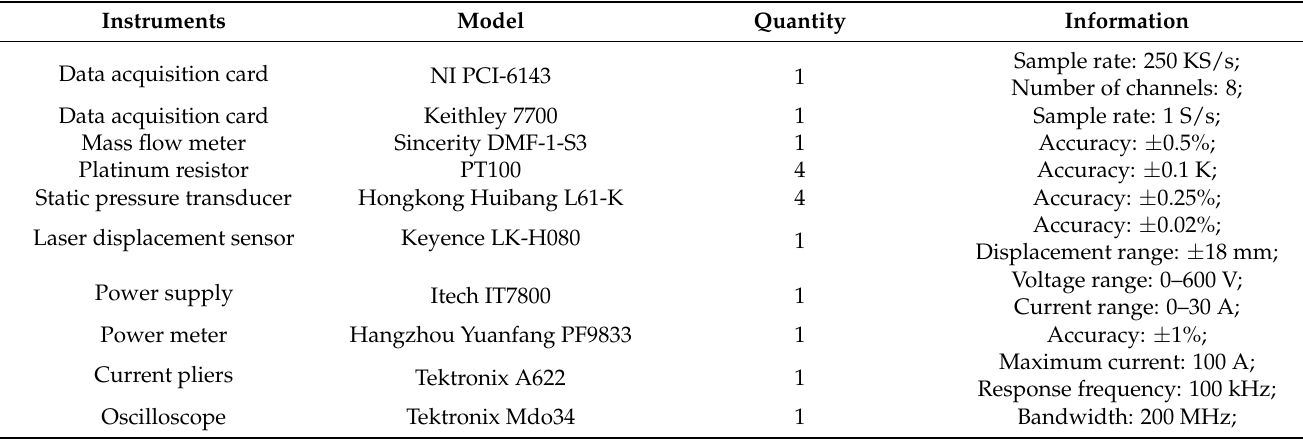
Table 4. The list of instruments in the experimental